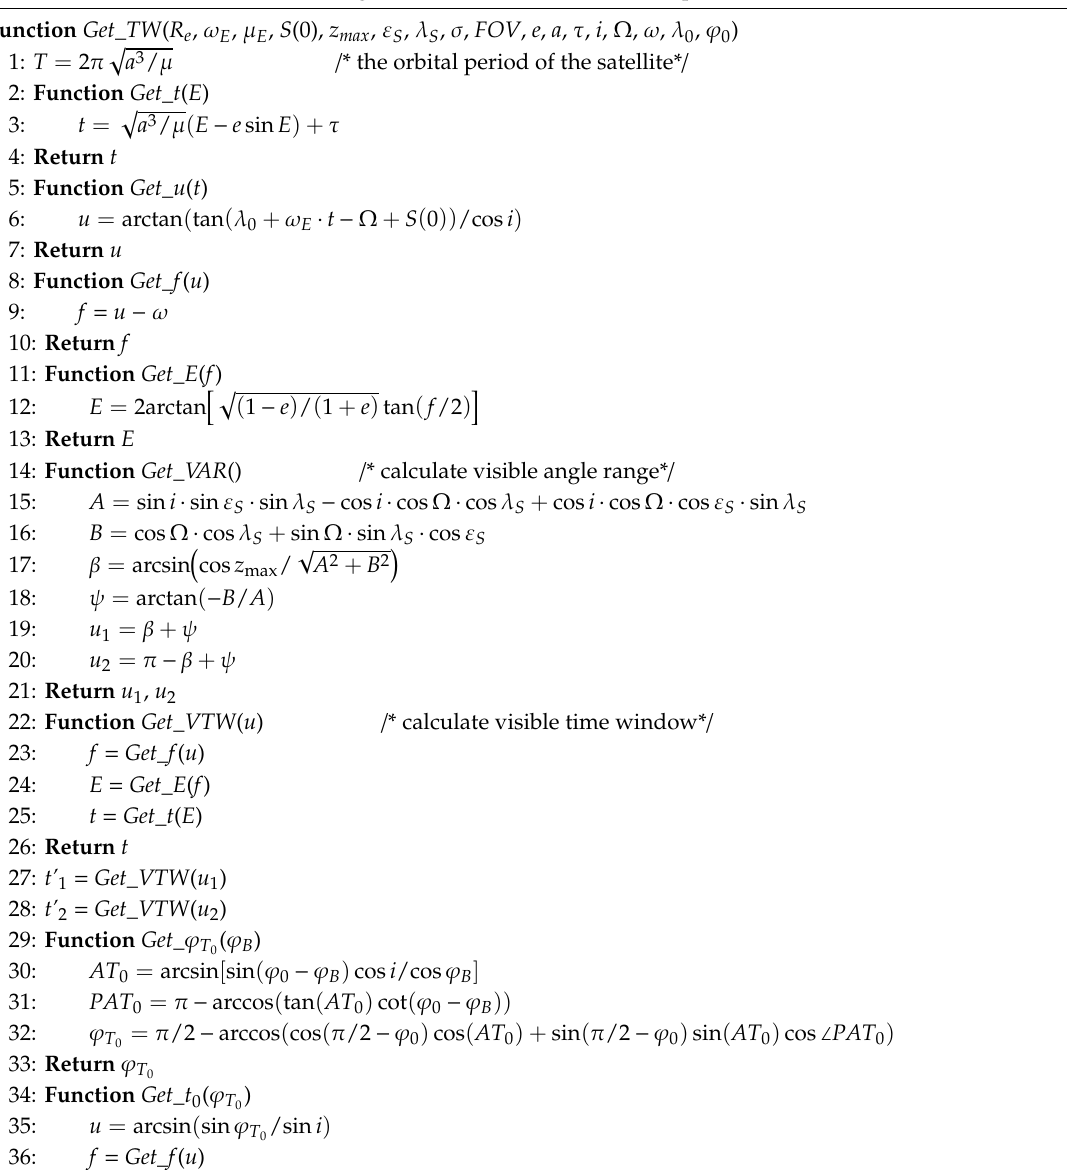
Algorithm A1 Function for calculating the available time window (elliptical orbit) Function Get_TW ( R e , ω E , µ E , S (0), z max , ε S , λ S , σ , FOV , e , a , τ , i , Ω , ω , λ 0 , ϕ 0